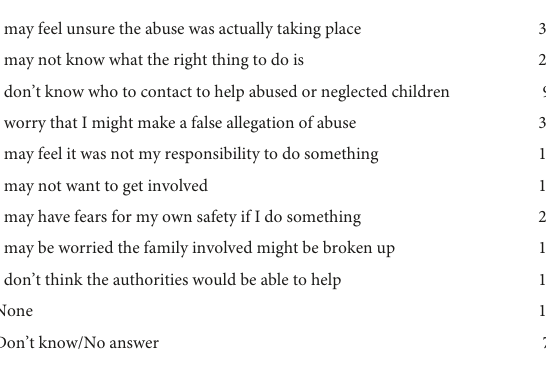
TABLE 5 Barriers to taking action to protect a child known to be